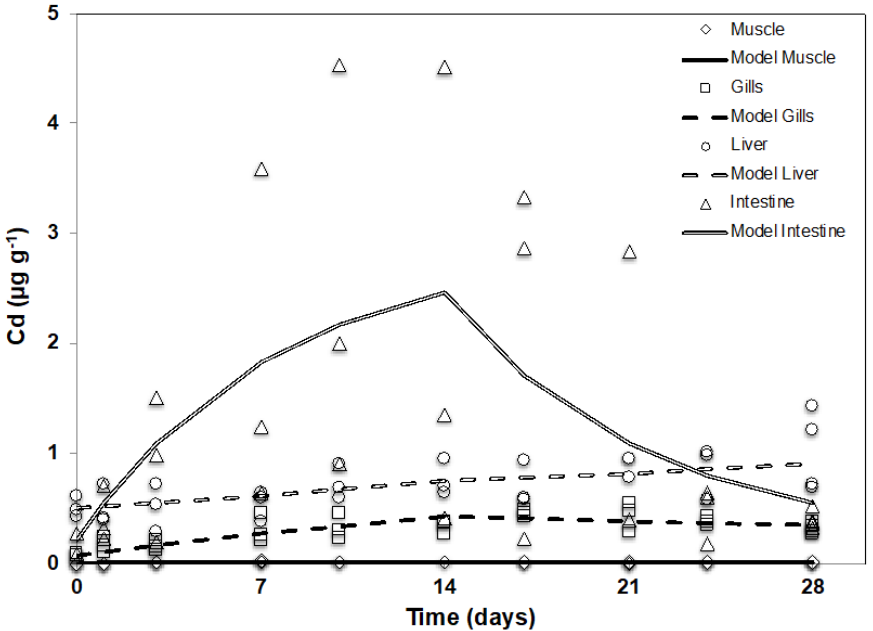
Figure 2. Uptake and elimination kinetics of cadmium in the muscle, gills, liver and intestine of juvenile Solea senegalensis exposed to cadmium-contaminated artificial seawater (ASW) and diet (polychaete Hediste diversicolor ). Symbols represent measured cadmium concentration in the different organs, and lines represent the predicted uptake and depuration using toxicokinetic models. Table 1. Uptake and depuration kinetics parameters of cadmium in the muscle, gills, liver and intestine of juvenile Solea senegalensis exposed to both cadmium-contaminated artificial seawater (ASW) and diet (polychaetes Hediste diversicolor ). C o is the initial (background) concentration in the sole’s tissues; u f is the total uptake flux (water and diet uptake flux) into the soles’ tissues; k 2 is the depuration rate; DT 50 is the time each tissue required to eliminate half the amount of cadmium; and C orgss is the concentration of cadmium at steady state (SE in brackets for C o values; 95% CI in brackets for u f and k 2 values).